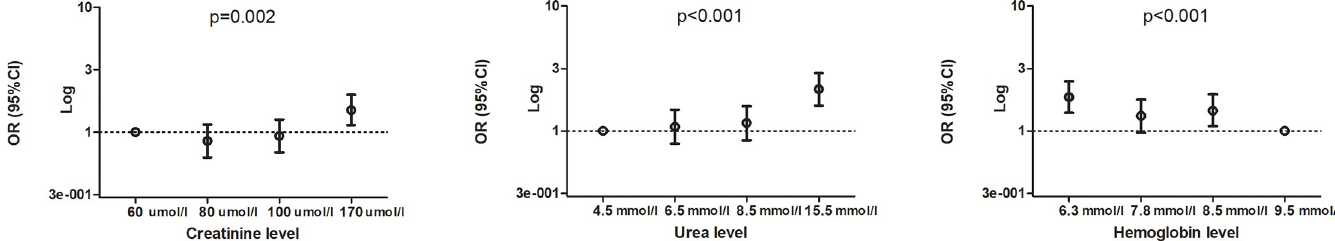
Fig 3. Quartiles of laboratory test results and their association with cognitive impairment. Abbreviations: umol/l = micromole per liter, mmol/l = millimole per liter, OR = odds ratio, 95%CI = 95% confidence interval, p = p-value. Y-axes is a logarithmic scale. The x-axes shows quartiles of the represented laboratory test result with the mean value within that category as label. The circle on the dotted line represents the reference category. Odds ratios and 95% CI’s can be found in S2 Table. Dot with bars represents the odds ratio with 95% confidence